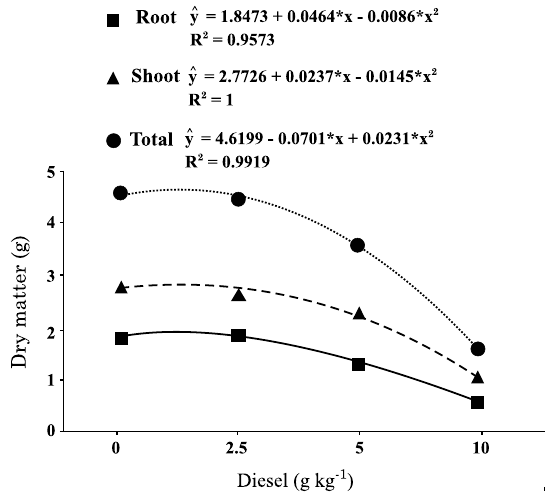
test.Figure 3. Root, shoot and total biomass of Brachiaria decumbens grown on control and diesel-treated soil after 10 weeks of analysis. *: significant